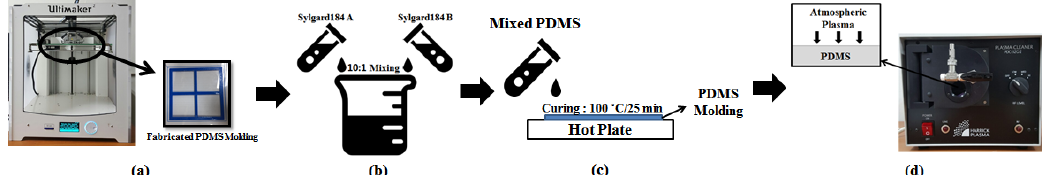
Figure 5. Fabrication process of the PDMS substrate; ( a ) Step 1: PDMS substrate outline, fabricated using a 3D printer; ( b ) Step 2: mixing the Sylgard184 A type and the Sylgard184 B type silicone elastomers; ( c ) Step 3: pouring PDMS into the outline and curing processing using hot plate; ( d ) Step 4: plasma treatment process.